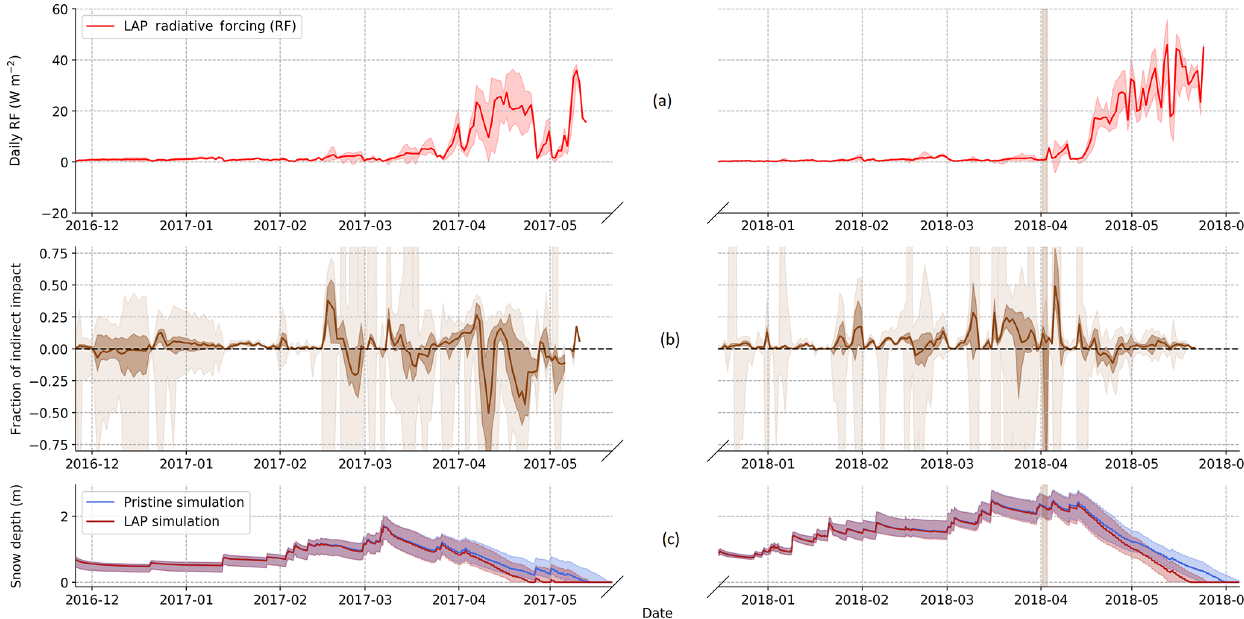
Figure 6. (a) Evolution of daily radiative forcing (RF) due to LAPs. This RF is computed as the difference of energy absorbed by the snowpack between the LAP and pristine simulations. (b) Evolution of the daily fraction of the indirect impact ( r ind ). The opaque shading corresponds to the ensemble members between the first and third quantile, while the light shading is the full ensemble spread. (c) Simulated snow depth for the pristine and the LAP simulations. The major dust deposition event of the second year is represented by brown shading.